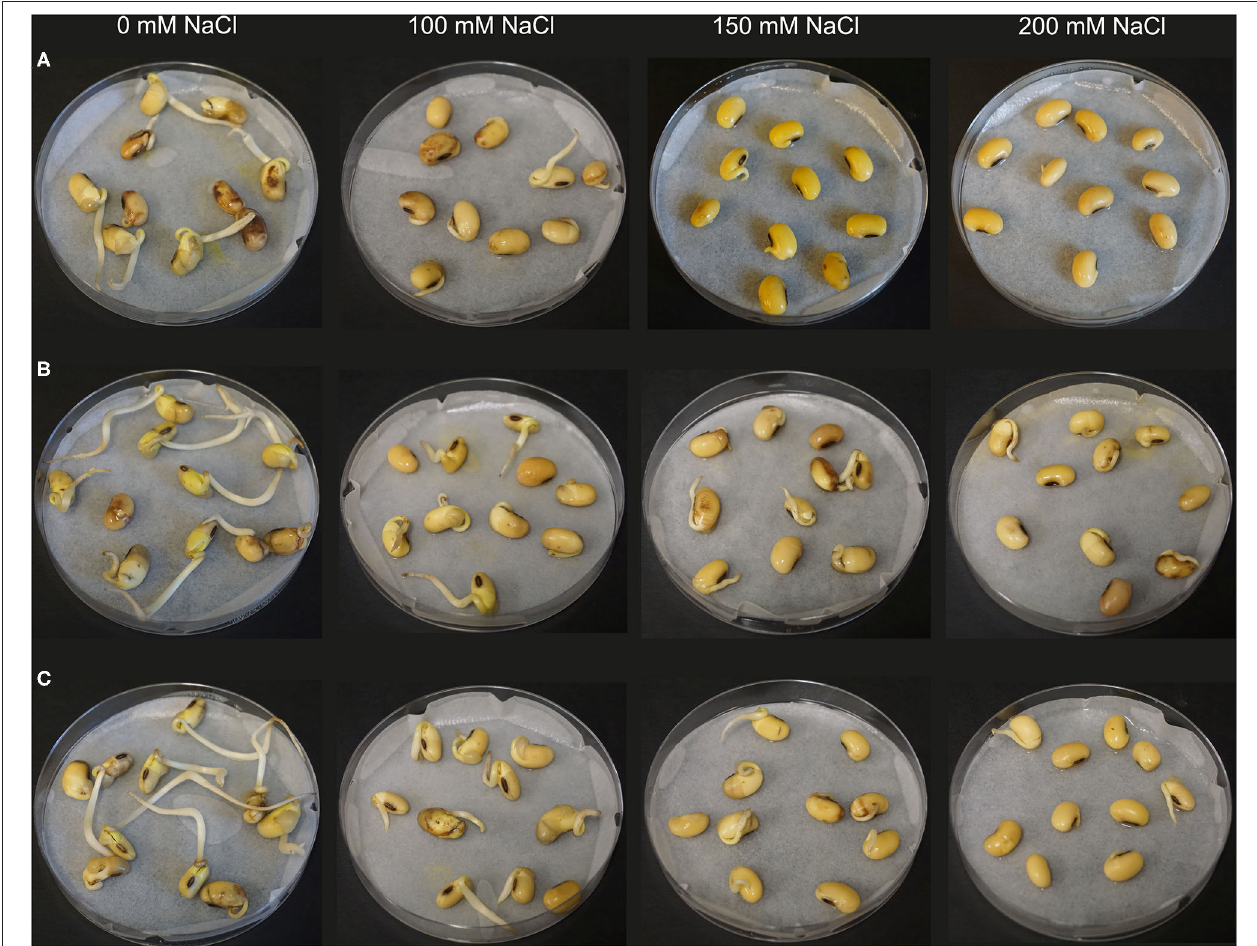
FIGURE 4 | Seed germination of soybean at 72h under increasing salt concentrations (0, 100, 150, and 200mM NaCl). The seeds were treated with (A) 10mM MgSO 4 as control or bacterized with strains (B) SL42 and (C)